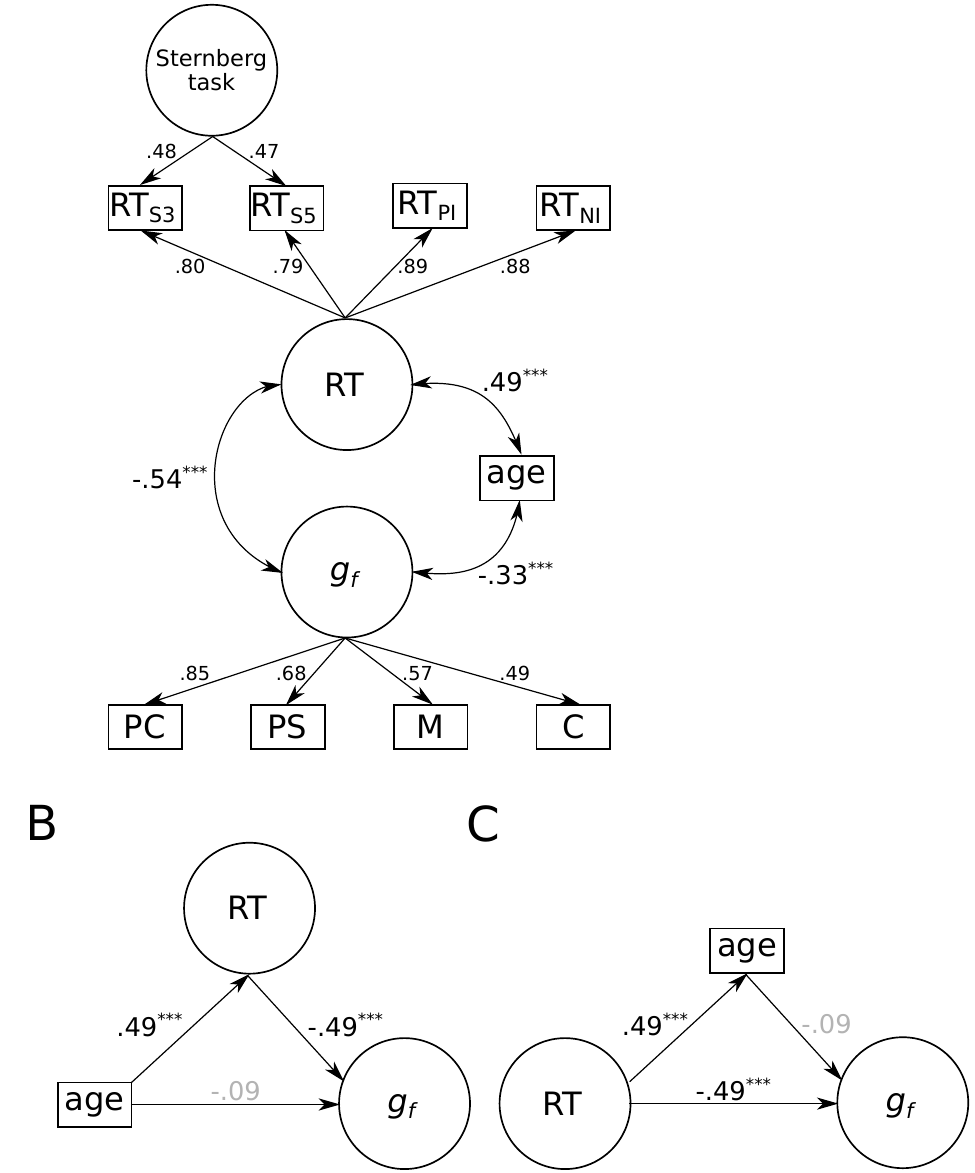
Figure 2. Graphical illustration of three structural equation models on the association between age, fluid intelligence, and reaction times. ( A ) Correlations between age differences, fluid intelligence, and reaction times. ( B ) Mediation of the association between age differences and fluid intelligence by reaction times. ( C ) Mediation of the association between reaction times and fluid intelligence by age differences. Standardized regression weights and correlation coefficients are shown next to paths with non-significant associations shaded in gray. RT = reaction time; g f = fluid intelligence; S3 = Sternberg task, memory set 3; S5 = Sternberg task, memory set 5; PI = Posner letter matching task, physical identity; NI = Posner letter matching task, name identity; PC = processing capacity; PS = processing speed; M = memory; C = creativity. N = 223. *** p <